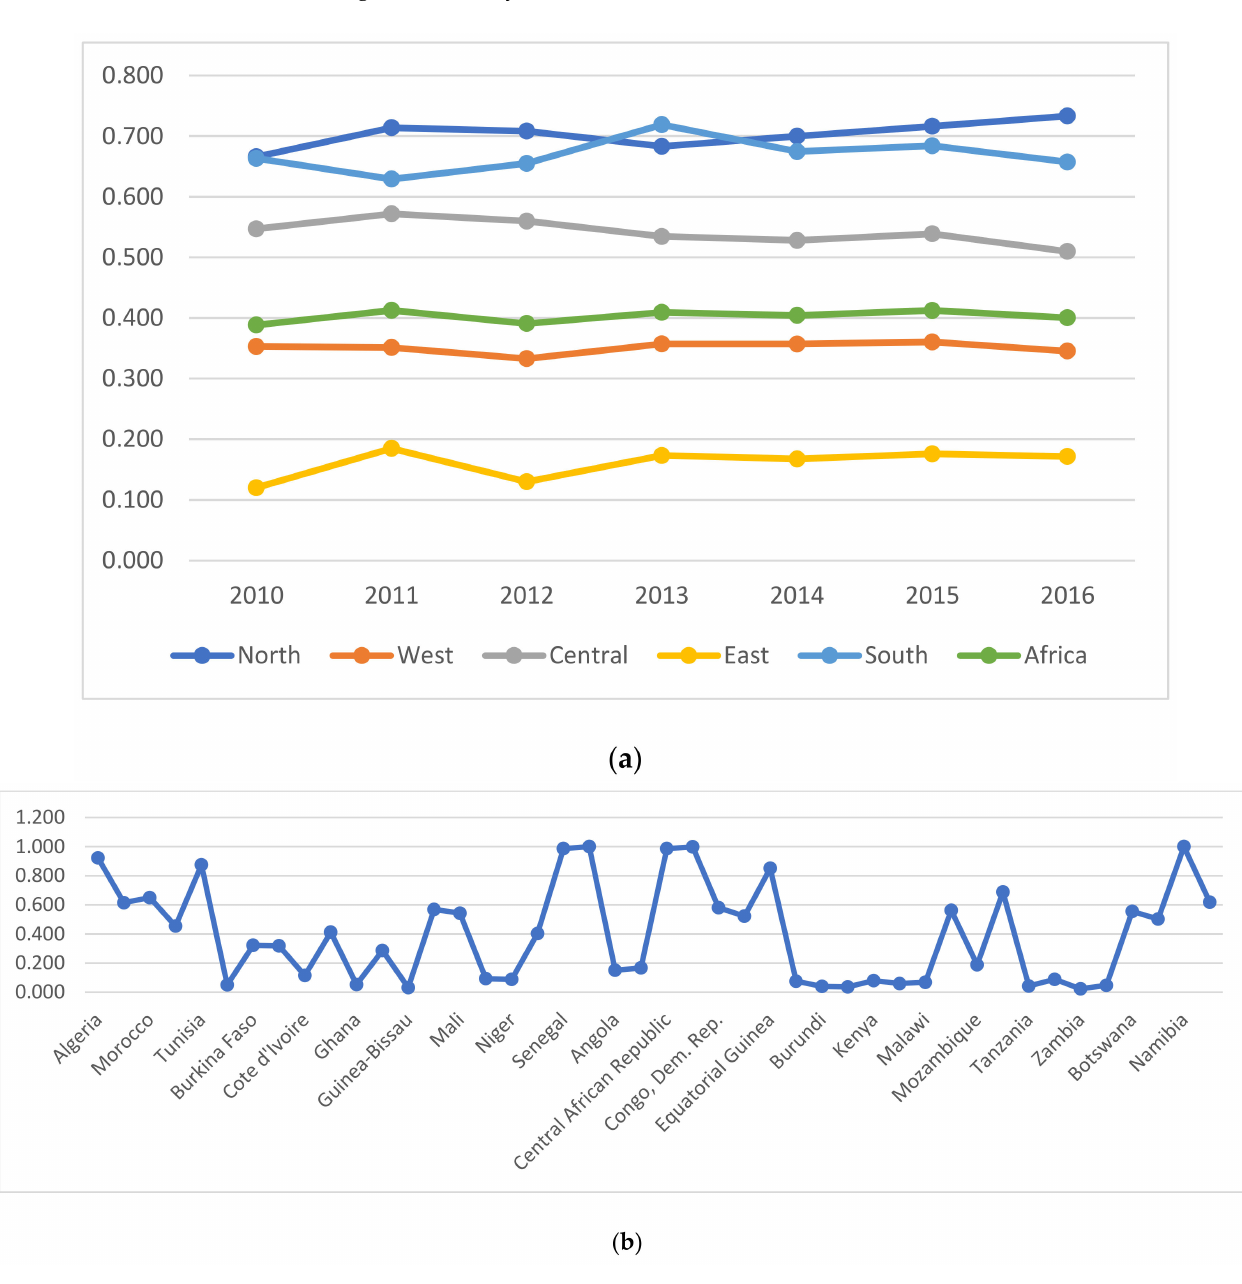
Figure 2. ( a ) Mean total efficiency by Africa blocs. ( b ) Overall mean dynamic ecological efficiency estimates by countries in